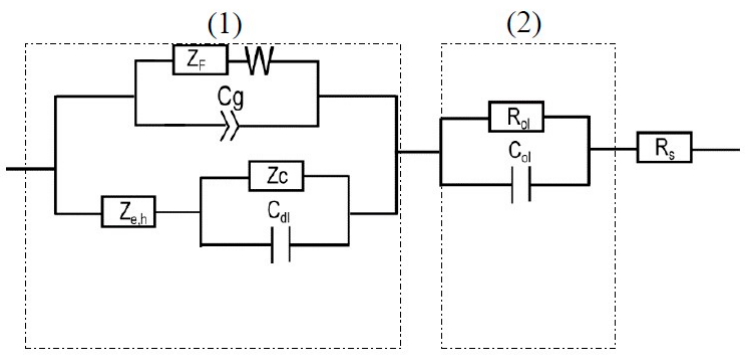
Figure 8. MPM equivalent circuit used for fitting EIS data of the passive layer on AA2098–T851 alloy in NaHCO 3 solution in contact with 1 atm CO 2 .